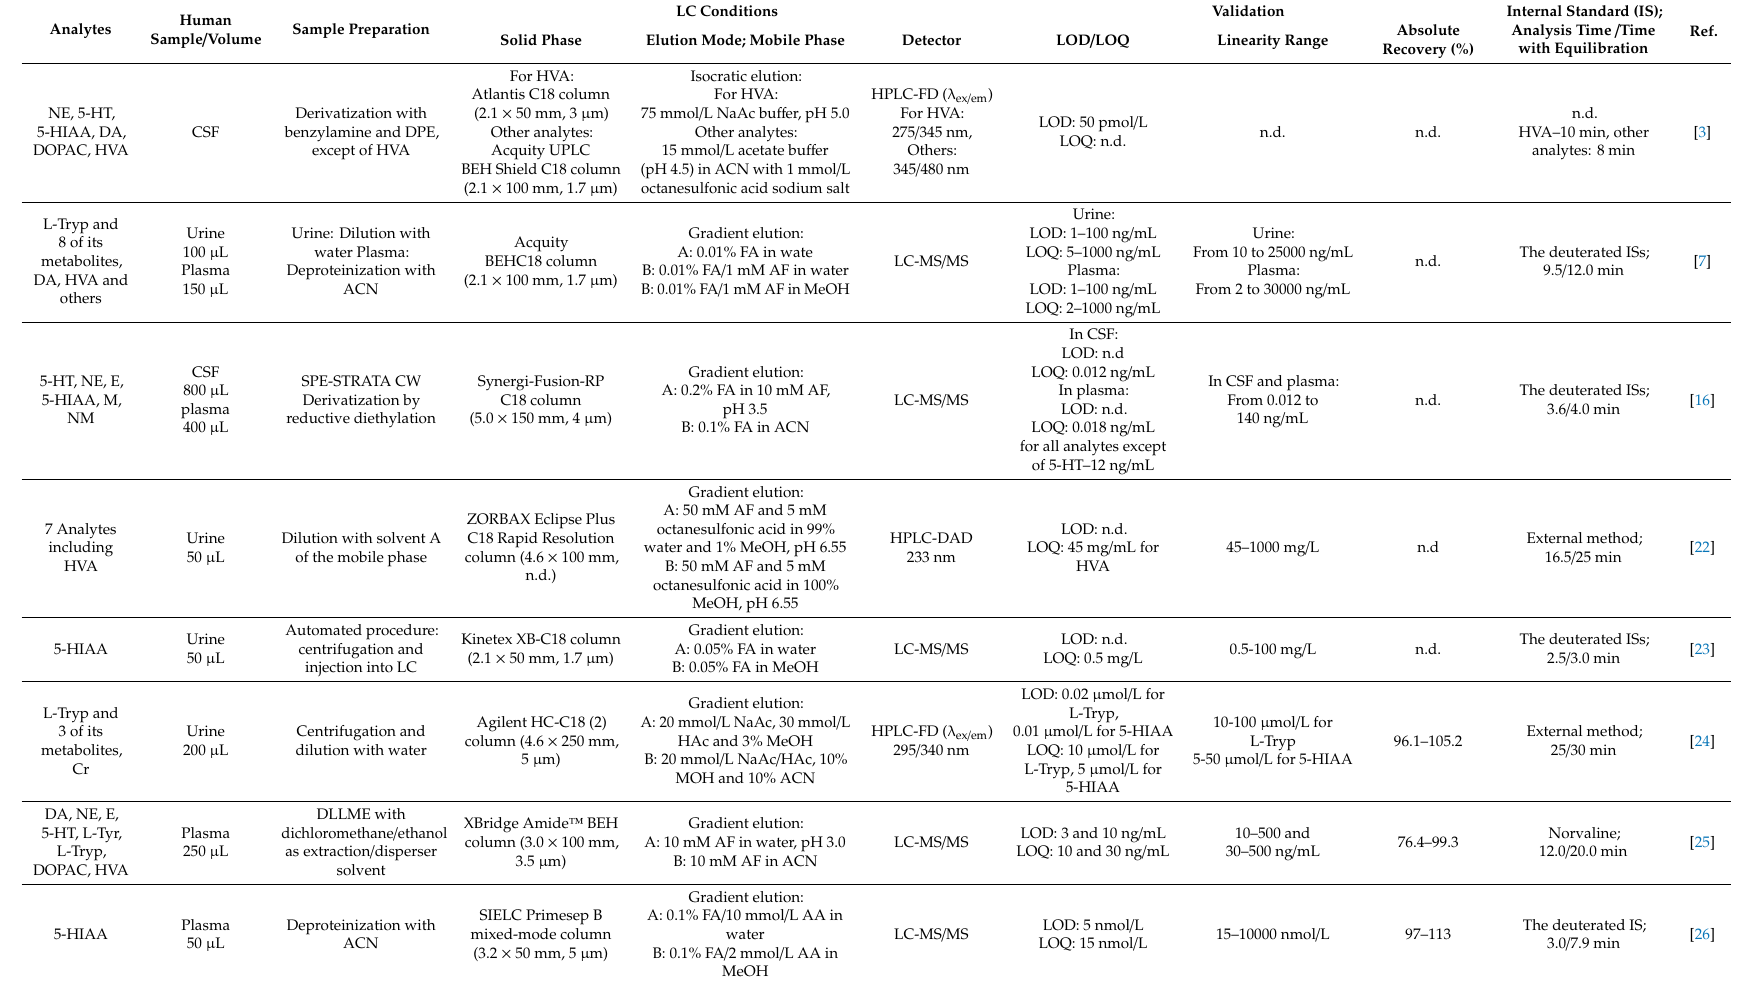
Table 2. LC methods for the separation of selected BAs in human specimens published since